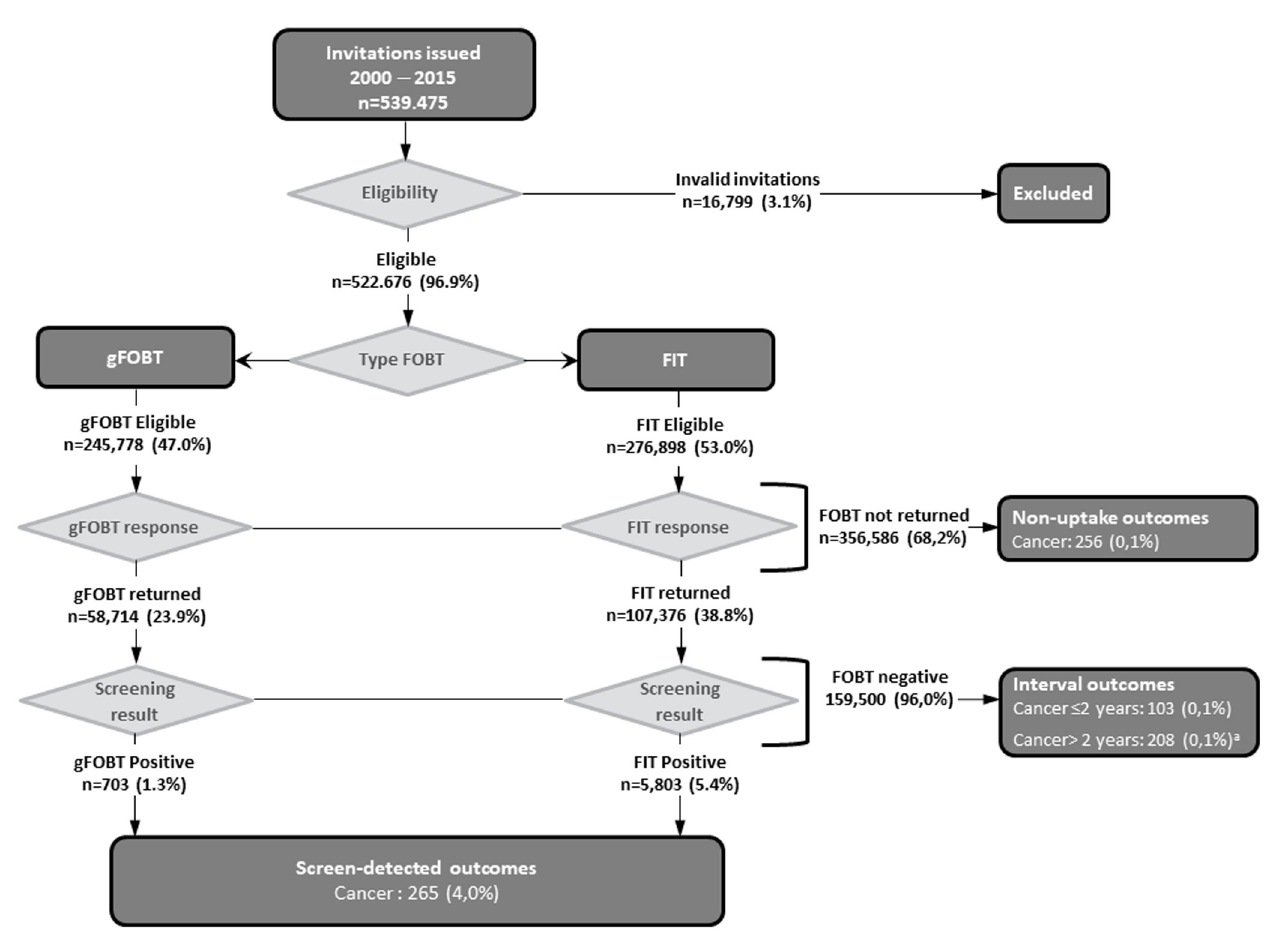
Fig 1. Colorectal cancers for the 2000–2015 invitee study group. a Colorectal cancer diagnoses > 24 months after FOBT analysis were excluded from the analysis. FOBT: faecal occult blood test; gFOBT: guaiac faecal occult blood test; FIT: faecal immunochemical test.